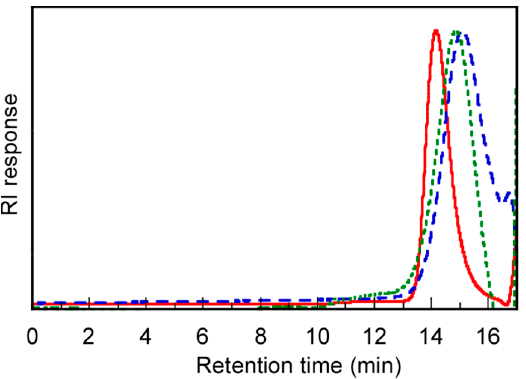
Figure 4. Gel-permeation chromatography (GPC) elution curves of PEG 54 -PAA 140 (—), PEG 54 -P(AA / VE35) 140 (– –), and PEG 54 -P(AA / VE6 / γ TCP29) 140 (—-) at 40 ◦ C using a phosphate buffer solution (PBS) at pH 9 containing 10% v / v acetonitrile as the eluent. Table 1. Number-average molecular weight ( M n ) and M n distribution ( M w / M n ). Sample